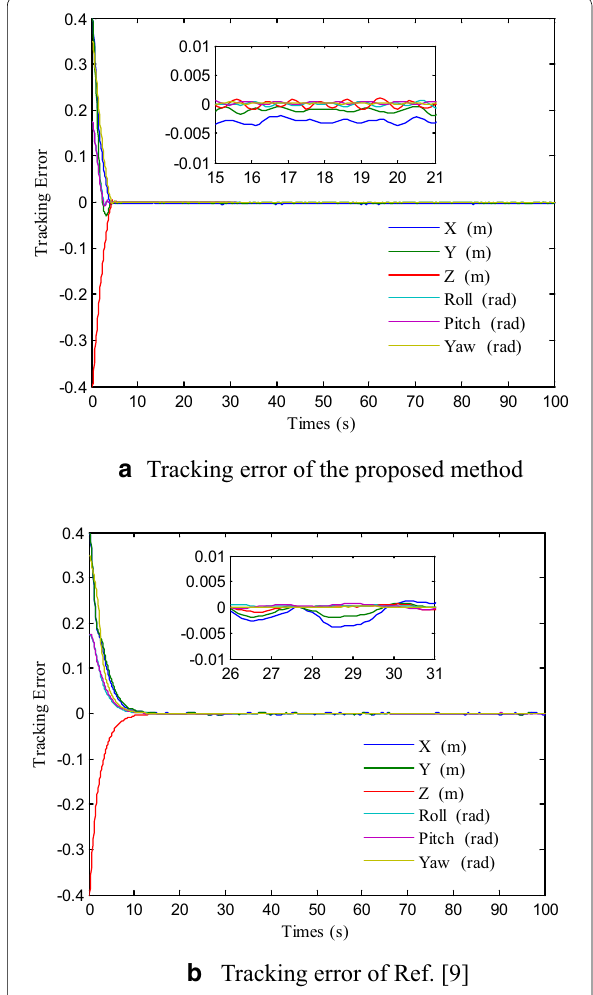
Figure 5 Tracking error in 0.3 m/s ocean current environment